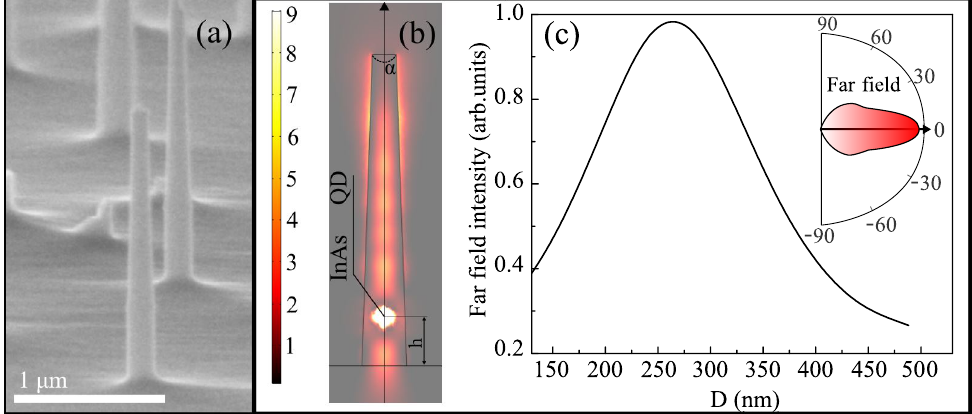
Figure 1. ( a ) Scanning electron microscopy image of the photonic nanoantennas. ( b ) Typical near-field distribution of electromagnetic energy in a photonic nanoantenna. ( c ) Far-field radiation intensity of nanoantenna, calculated for different diameters of the nanoantenna’s base, normalized to maximum intensity. Inset shows the typical far-field angular distribution of the